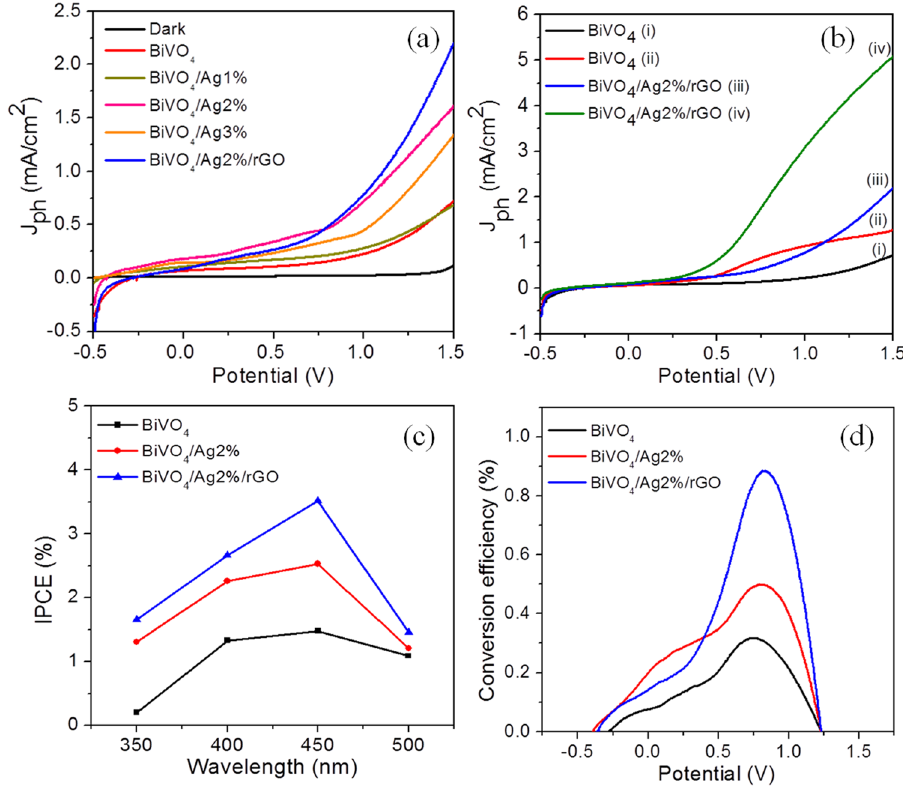
Figure 5. ( a ) Photocurrent density-voltage (J-V) characteristics of the samples under dark and illumination conditions using 0.5 M Na 2 SO 4 as electrolyte solution. ( b ) Comparative J-V curves of the BiVO 4 sample (i, ii) using 0.5 M Na 2 SO 4 and 0.5 M Na 2 SO 3 as electrolyte, respectively, and (iii, iv) J-V curves for the BiVO 4 /Ag/ rGO sample using 0.5 M Na 2 SO 4 and 0.5 M Na 2 SO 3 as electrolyte, respectively. ( c ) Solar to hydrogen conversion (STH) efficiency. ( d ) Incident photon to current conversion efficiency (IPCE) calculated from wavelength dependent current voltage